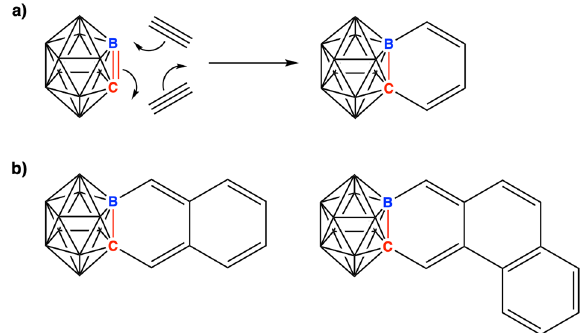
Fig. 6 3D + 2D formation. a [2 + 2 + 2] cycloaddition between o - carboryne and alkynes; b structures of fused carborane and